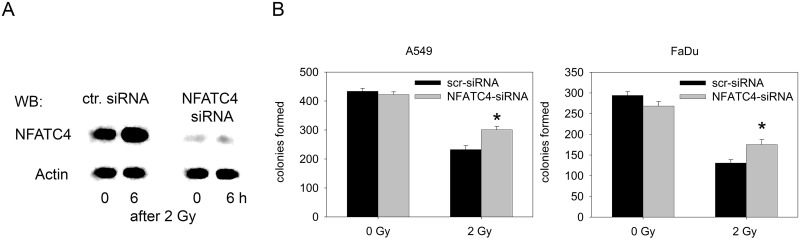
Inhibition of NFATC4 expression and its effect on clonogenic survival.A: Expression of the NFATC4 protein in A549 cells after irradiation and treatment with the NFATC-siRNA. B: Colony formation assay using A549 and FaDu cells after irradiation and treatment with the NFATC4 siRNA (two sample t-test; *p< 0.05 compared to scr-siRNA).